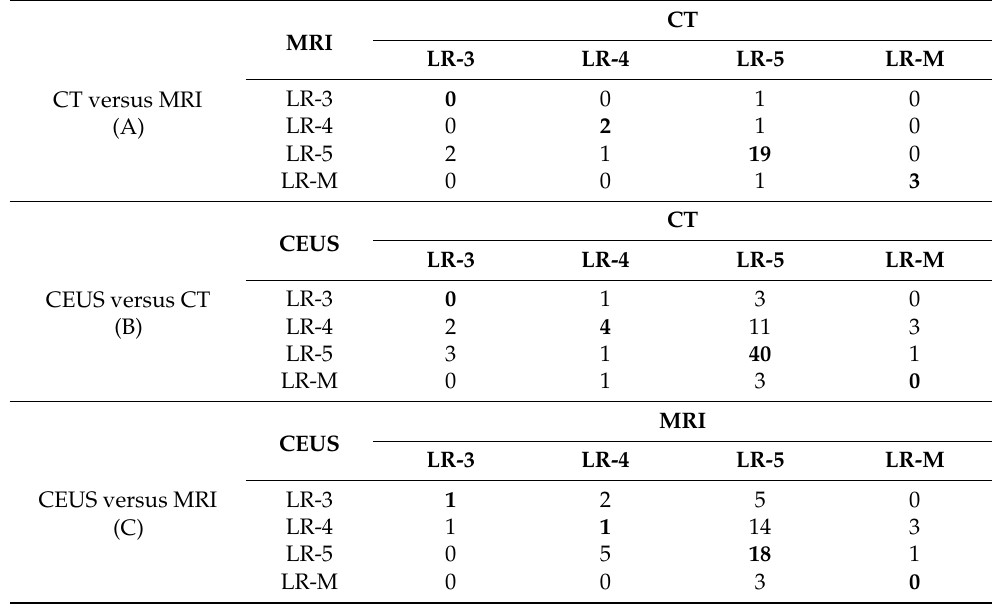
Table 6. Agreement for LI-RADS category assignment between: A—CT versus MRI; B—CEUS versus CT; C—CEUS versus